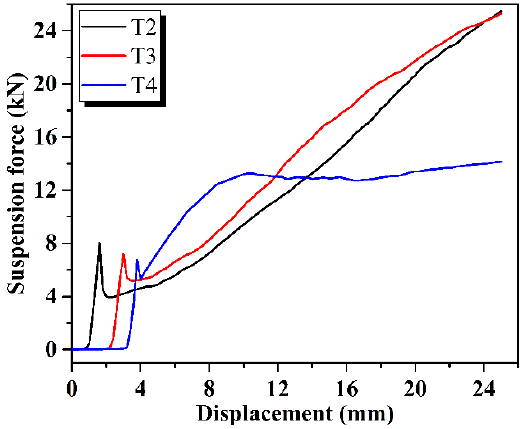
Figure 16. Suspension force